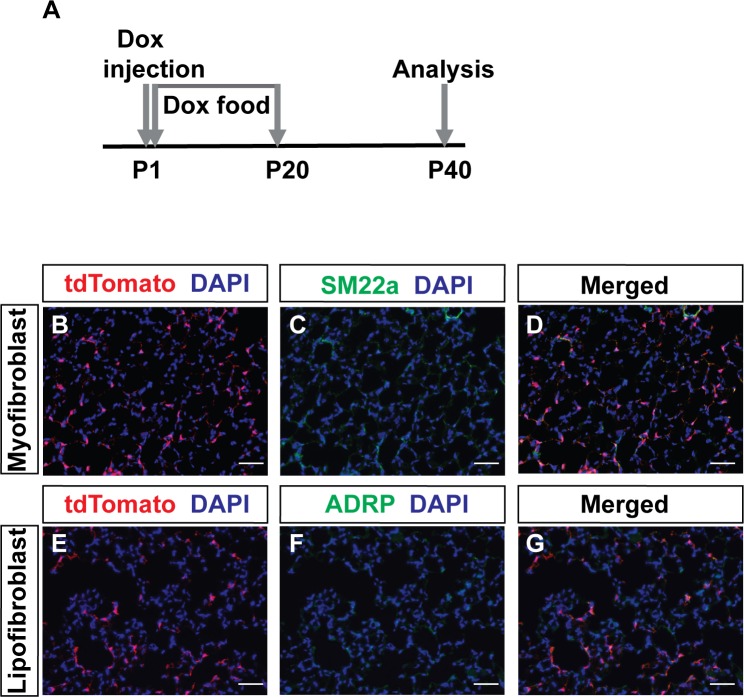
Lineage tracing of PDGFRa cells to adult.(A) Timeline of dox treatments and analysis. (B–G) Representative immunofluorescent staining of PdgfrartTA;tetO-cre;Rosa-tdTomato mice at P40. Markers include: tdTomato (red), SM22a (green) and DAPI (blue) (B–D); and tdTomato (red), ADRP (green) and DAPI (blue) (E–G). Scale bars: 50 µm.